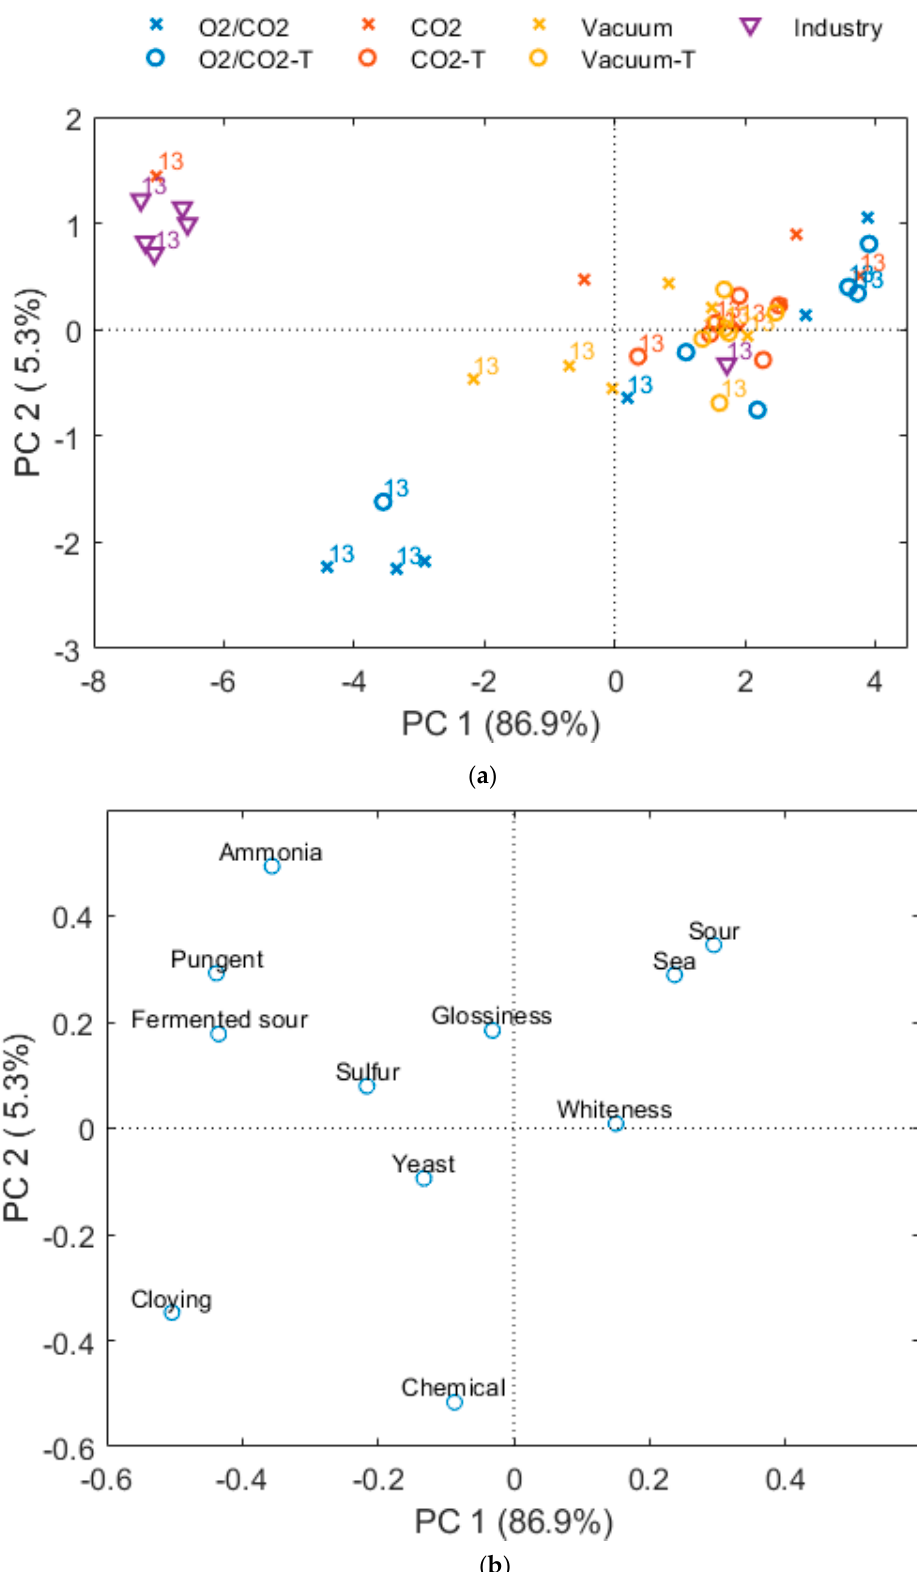
1 positive associated odor attributes; Green color means that scores are significant different to “Industry” ( p = 0.05), and orange color means score different to both “Industry” and the other packaging methods.